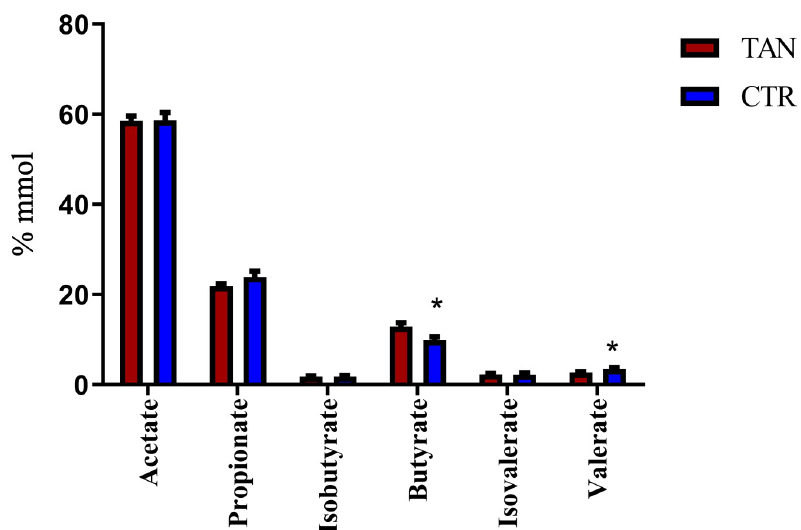
Fig 5. Proportion of short-chain fatty acids in control (CTR) and tannin-fed (TAN) piglets. The � indicates a p value �